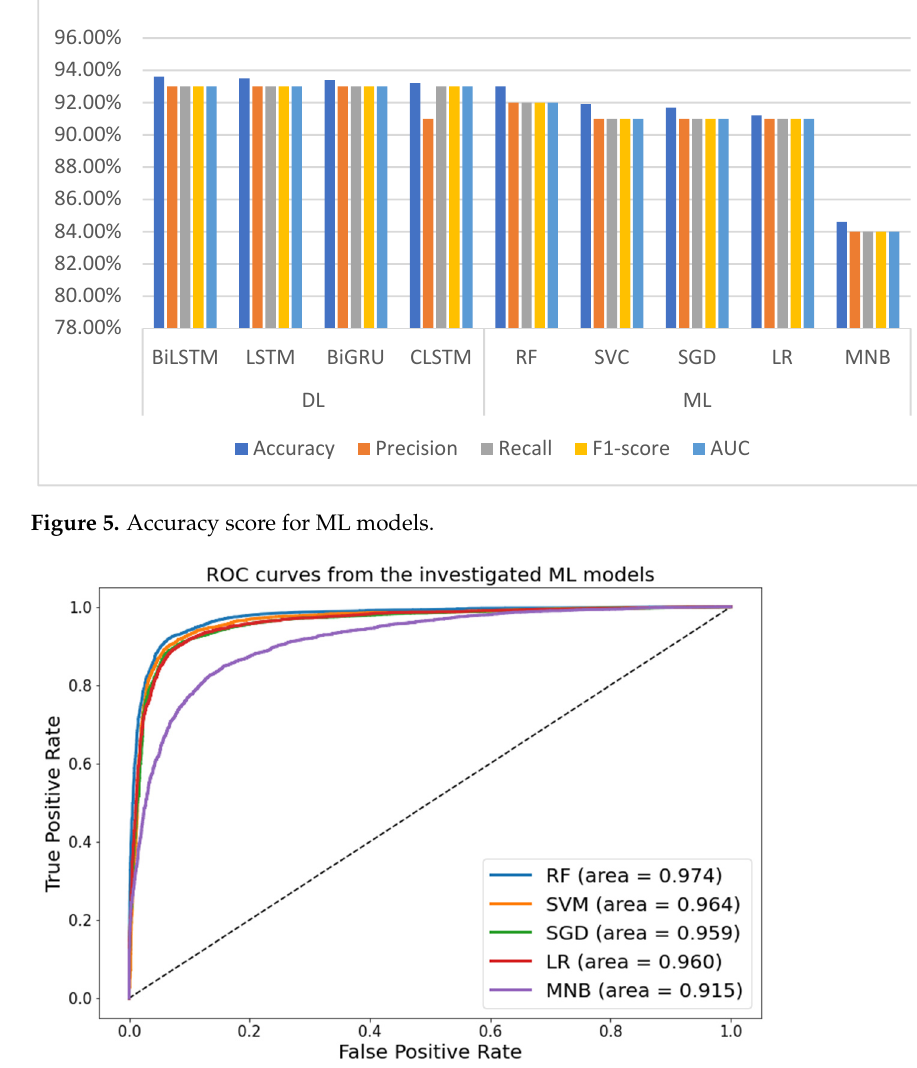
( b ) Figure 7. Confusion Matrix of best performed model of ML and DL ( a ) Random Forest; ( b ) BiLSTM. 4.3. Model Validation To better understand the learning mechanism, we used k-fold cross-validation to de- termine the mean accuracy in our model. Cross-validation is one of the most extensively used data resampling strategies for assessing the generalization capabilities of predictive models and estimating the actual estimation error of models. The learning set is divided